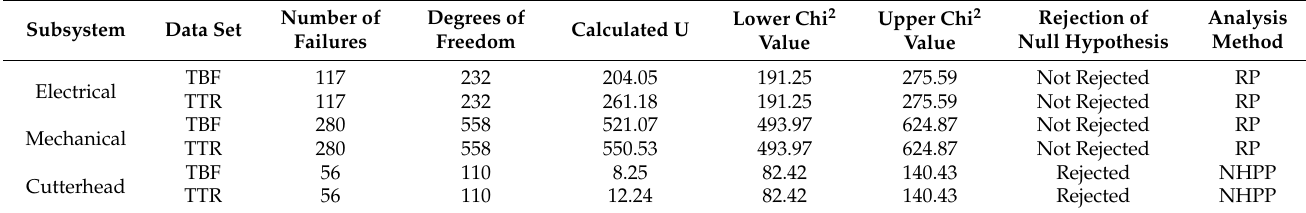
Table 6. Results of trend test on TBFs and TTRs of all subsystems.